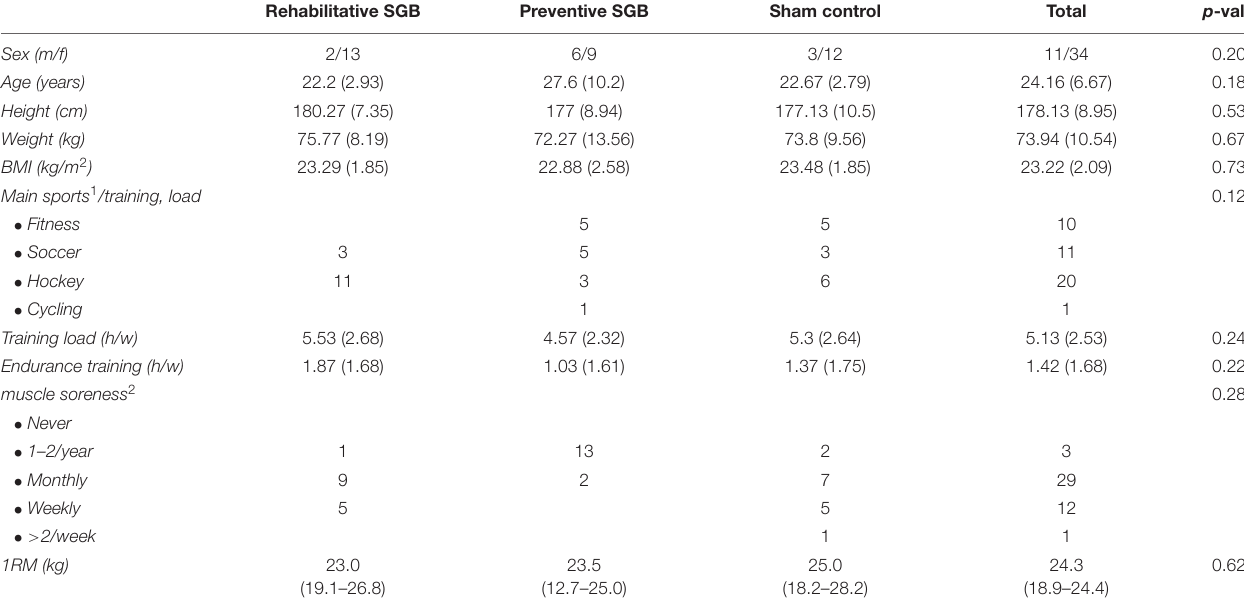
TABLE 1 | Demographic data, except 1RM data are presented as mean (SD), 1RM as median (95%-CI). Rehabilitative SGB Preventive SGB Sham control Total p